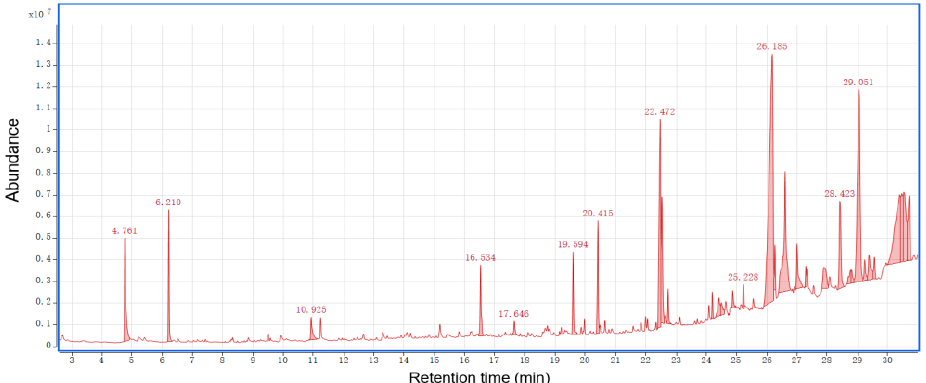
Figure 11. Total ion chromatograms of RPB methanol extract.